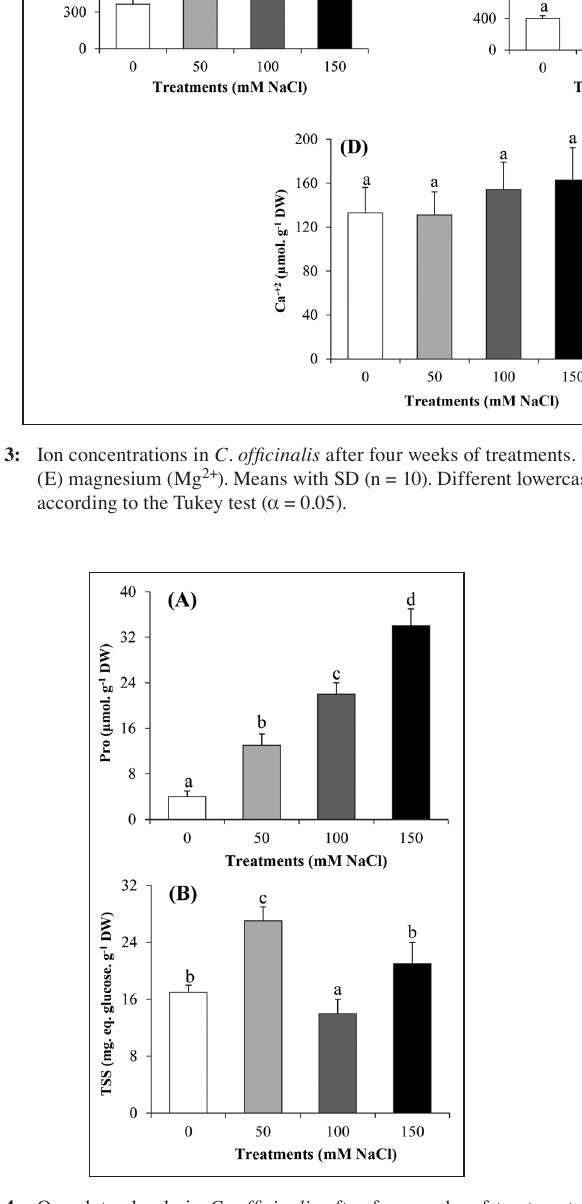
Fig. 4: Osmolytes levels in C. officinalis after four weeks of treatments. (A) Proline (Pro) and (B) total soluble sugars (TSS). Means with SD (n = 10). Different lowercase letters above the bars indicate signifi- cant differences between NaCl treatments according to the Tukey test (α =